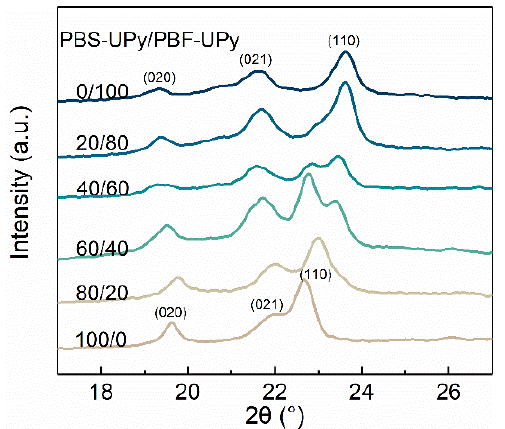
Figure 7. Wide angle X-ray diffractograms of PBS-UPy/PBF-UPy blends after being cooled from melt to 20 °C at a rate of 40 °C/min.